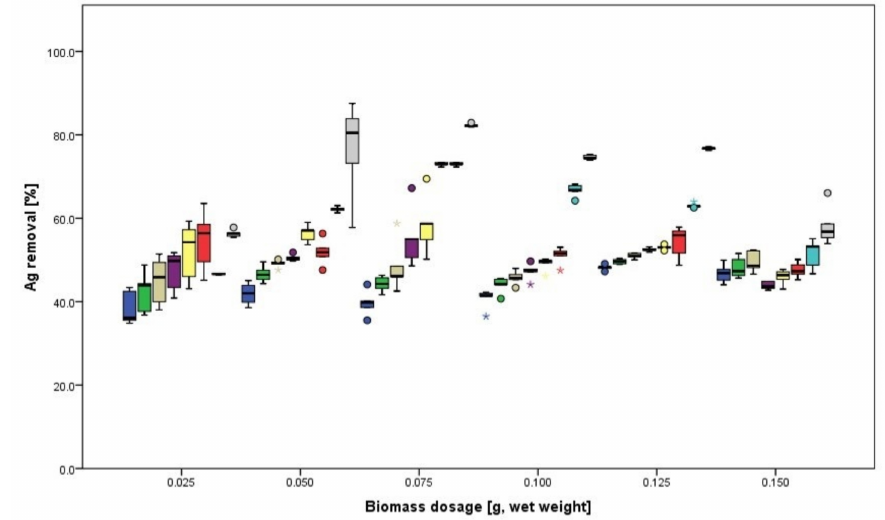
Figure 10. Ag removal by different dosages (wet weight) of Aspergillus tabacinus pellets and at different contact times. (cid:4) : 1 h; (cid:4) : 2 h; (cid:4) : 3 h; (cid:4) : 4 h; (cid:4) : 5 h; (cid:4) : 6 h; (cid:4) : 12 h; (cid:4) : 24